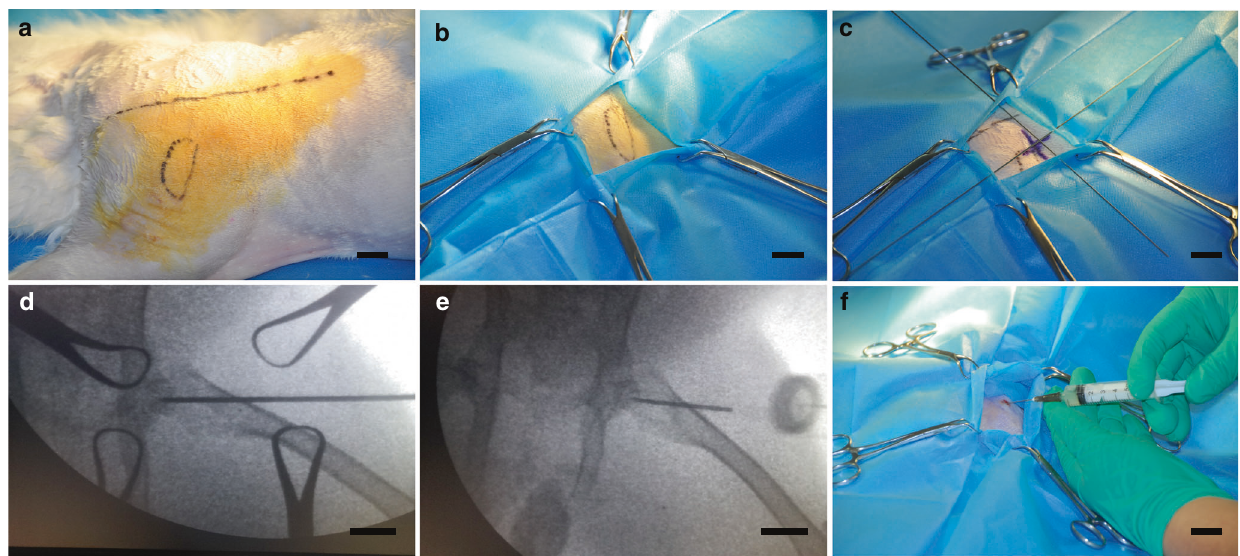
Fig. 4 Surgical procedure. a Skin preparation and disinfection after anesthetization. b Sterile sheet preparation at the surgical site. c Femoral head orientation using a homemade surgical guide. d Core decompression using a needle. e Injection orientation. f Injection of ZA-loaded GPCL through an 18G needle. Scale bar: 1